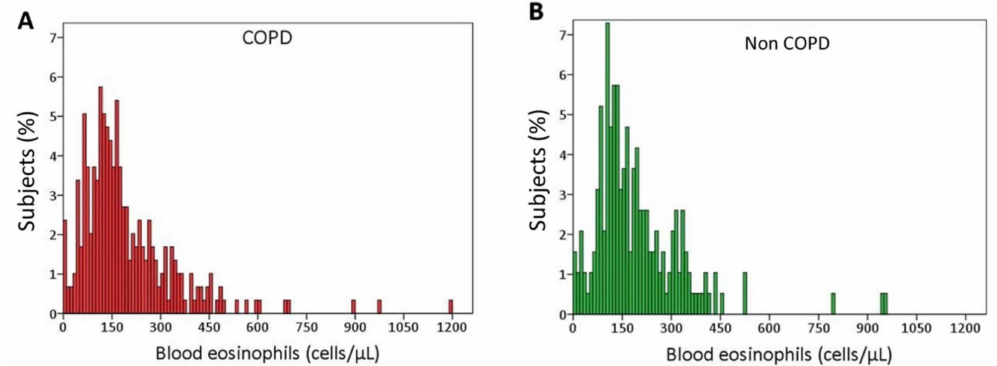
Figure 1. Distribution of blood eosinophils. Blood eosinophils distributions (in the blood sample obtained at patients recruitment) in a group of “real life” smokers followed for 5 years. ( A ) Smokers with chronic obstructive pulmonary disease (COPD) ( n = 303) median, interquartile range: 156, 101–250 eosinophils µ L − 1 . ( B ) Smokers without COPD ( n = 209) median, interquartile range: 160, 107–256 eosinophils µ L − 1